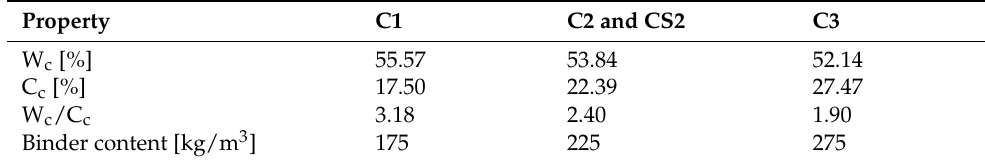
Table 5. Parameters of different